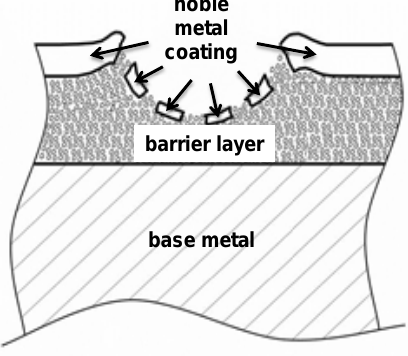
Figure 4. Wear pattern II—partial wear out of the final coating and contact surface not totally covered with